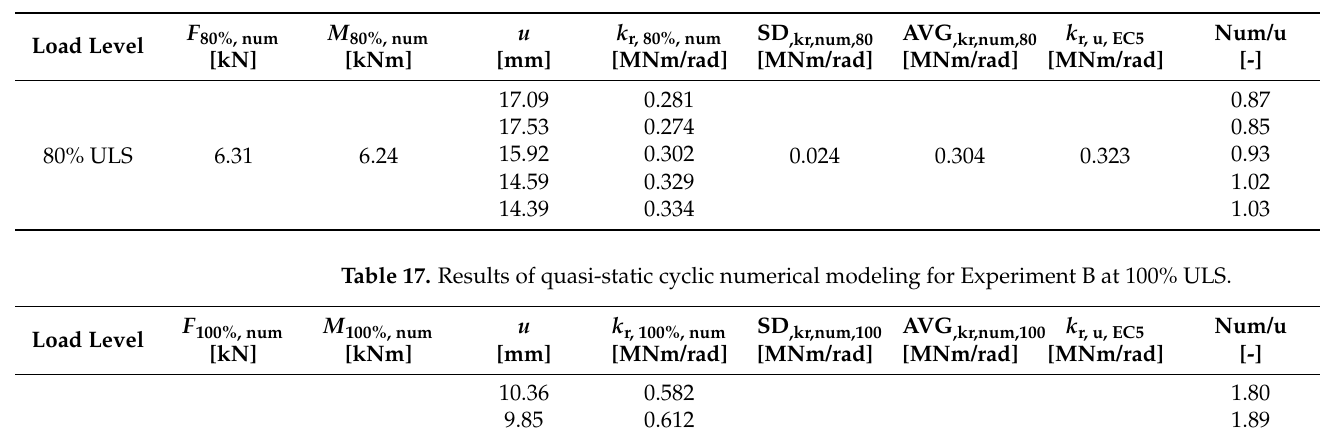
Table 16. Results of quasi-static cyclic numerical modeling for Experiment B at 80% ULS.